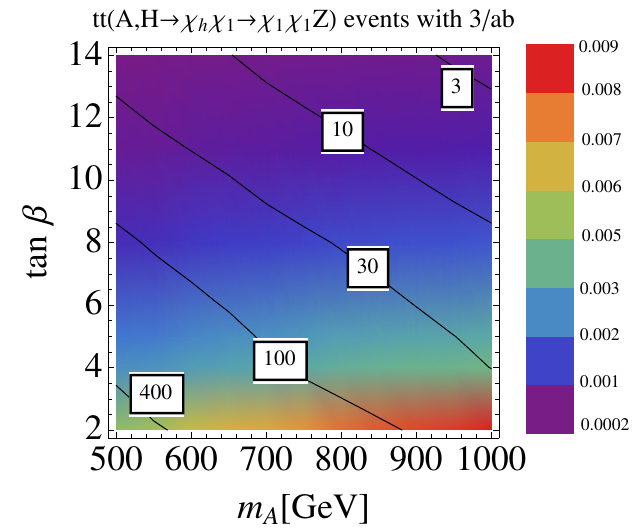
Figure 12 . Number of pp ! t (cid:22) t ( A; H ) ; A=H ! (cid:31) 1 (cid:31) h ; (cid:31) h ! (cid:31) 1 Z events (summed over both A and H ) expected at the HL-LHC. Here we choose (cid:22) such that m (cid:31) m (cid:31) = m (cid:31) (cid:0) 100 GeV. The color coding shows the ratio of this production cross section to the cross 1 3 section of mono-Z events from direct production of the electroweakino states, pp ! (cid:31) i (cid:31) j ! Z + =E T . 5.1 Topologies with Higgs associated production and A=H ! (cid:31) (cid:31) 1